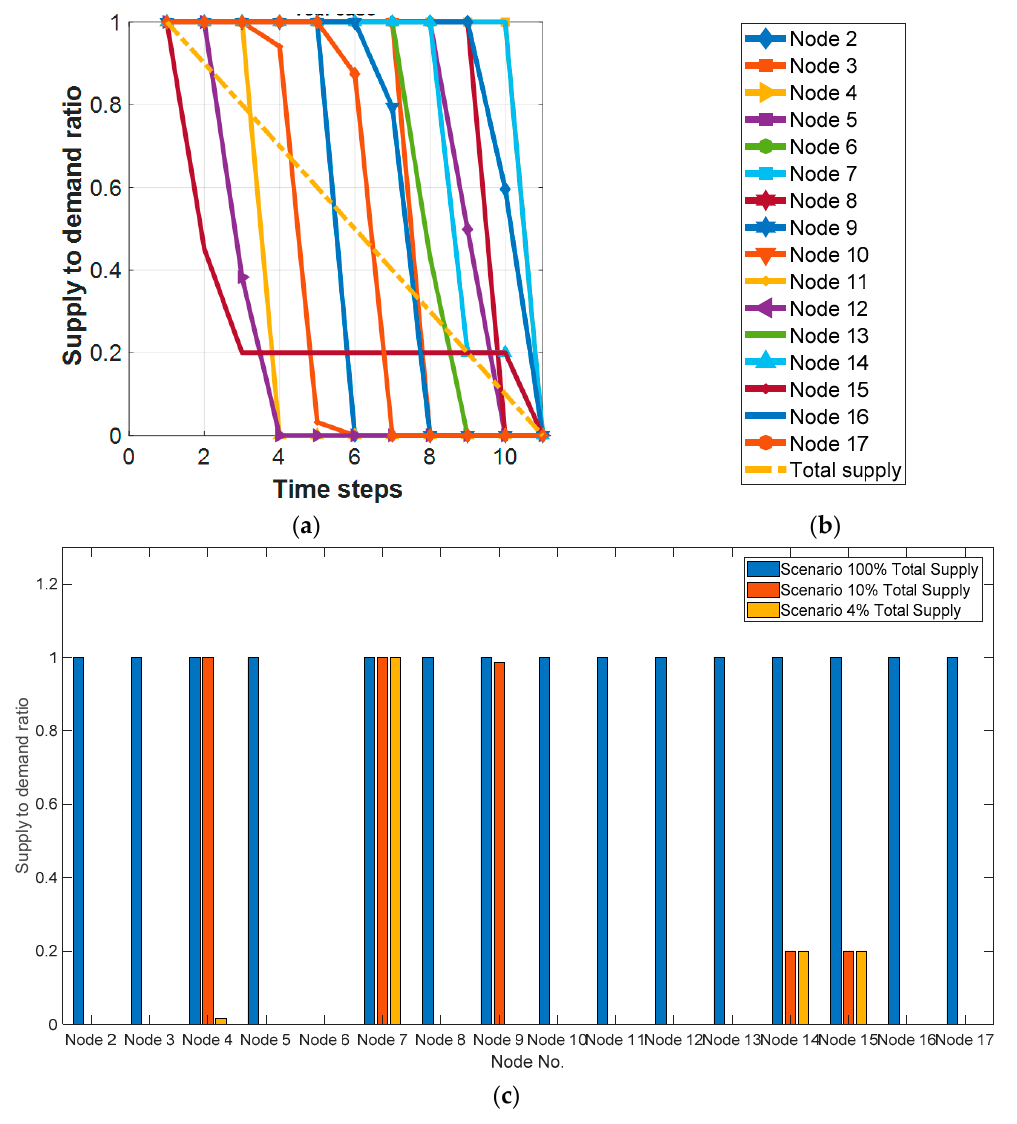
Figure 11. The final results that are based on an assumption of probability profile from the flood model and assumed cost profile. Here, we assumed the cost profile is stepwise only for Node 7, Node 14, and Node 15, and the three vulnerable flooding nodes (Node 1, Node 6, and Node 14). ( a ) Resulted scenario, considering the cost profile for the three nodes without any flooding probability included with reducing the supply 10% gradually; ( b ) the legend of lines in ( a ); ( c ) Scenarios considering both flooding and stepwise cost profiles with reducing of supply based on the flood model results; the supply/demand ratio value with 0 did not show in the bar.